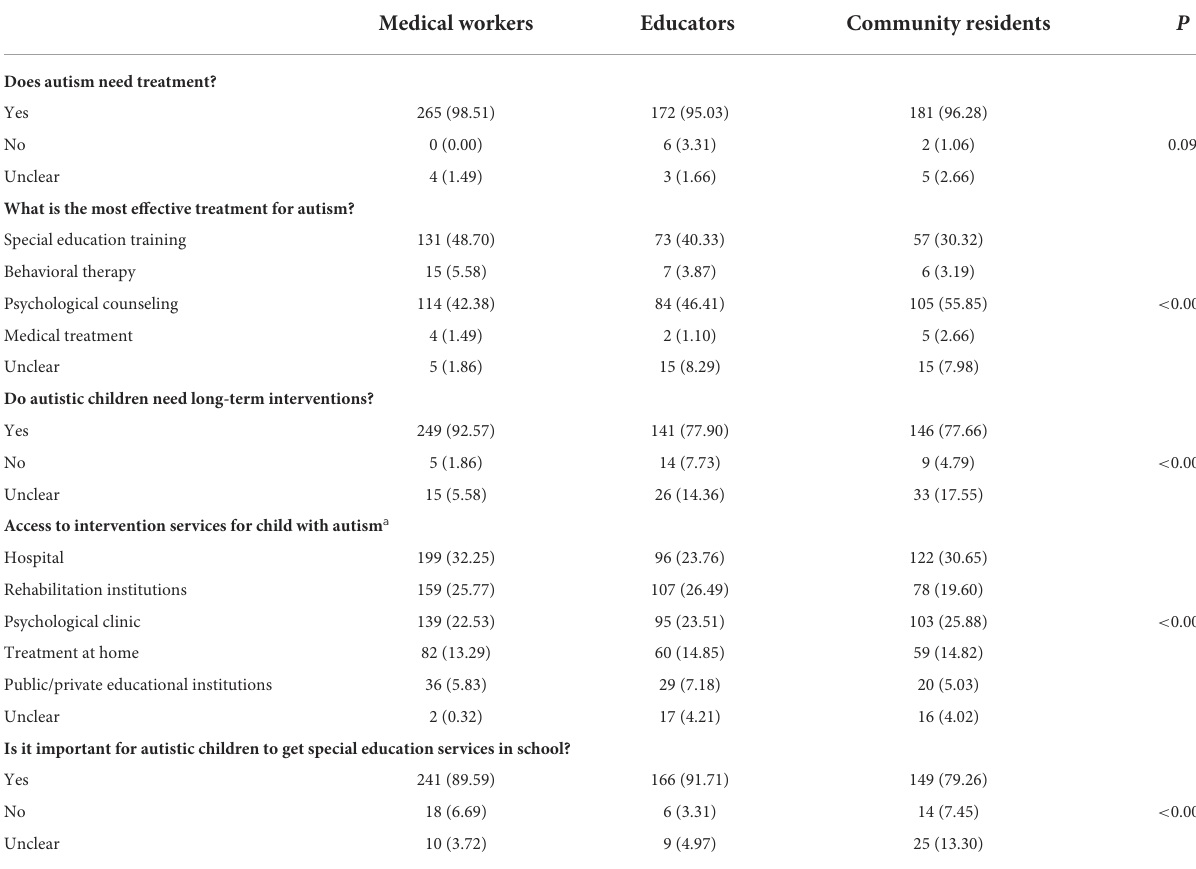
TABLE 4 Awareness of interventions for ASD ( n , %). Medical workers